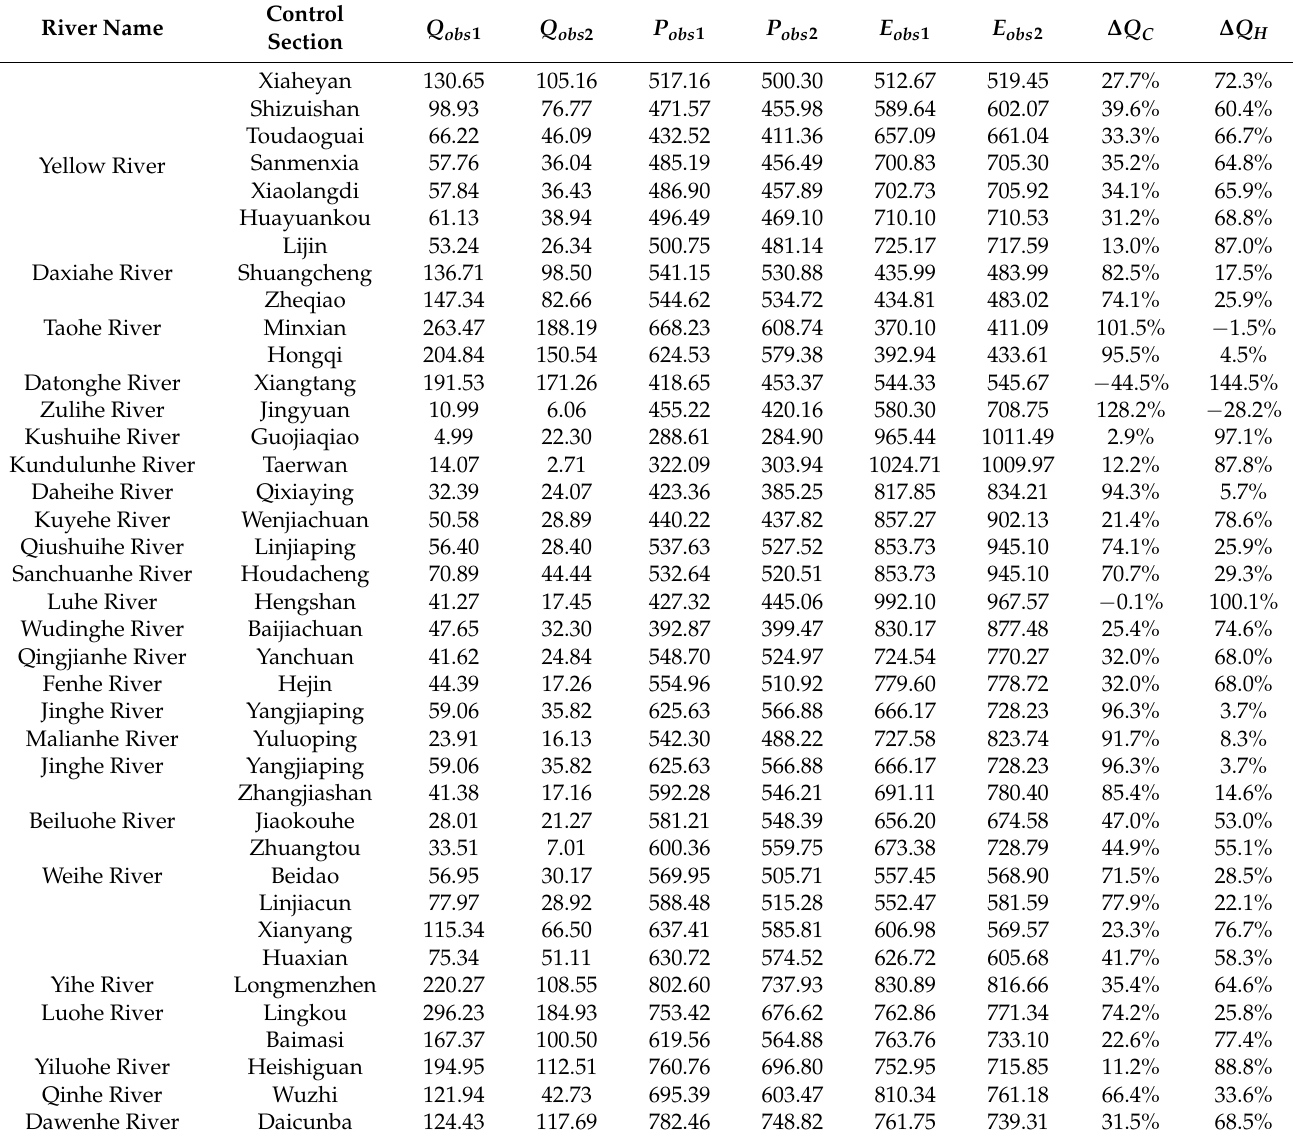
Table 6. Contribution of climate change and human activity in the main control sections of the Yellow River